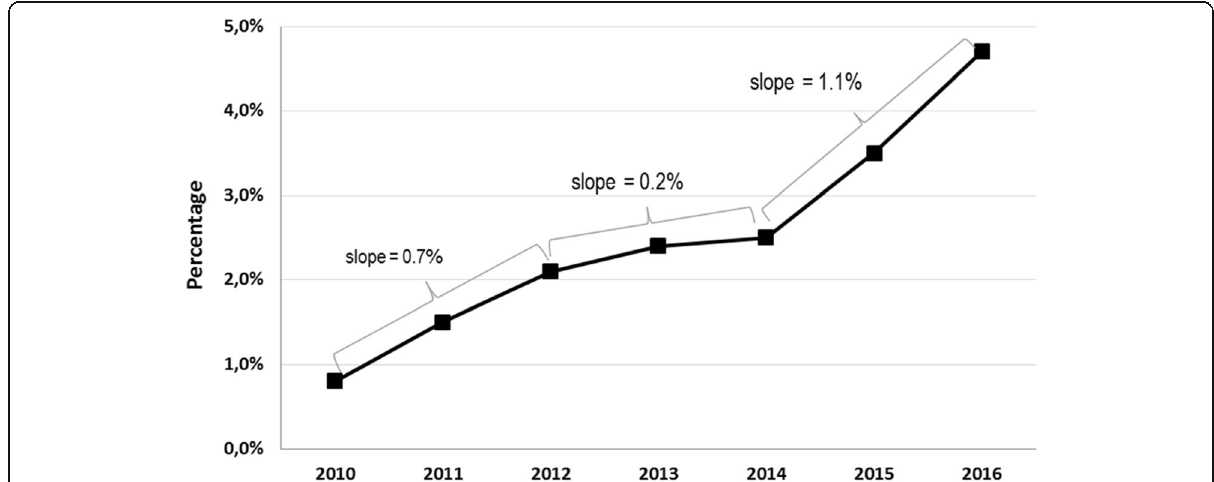
Fig. 2 Temporal evolution of mechanical thrombectomy rates in Germany between 2010 and 2016 (Slope is given as absolute percentage points per